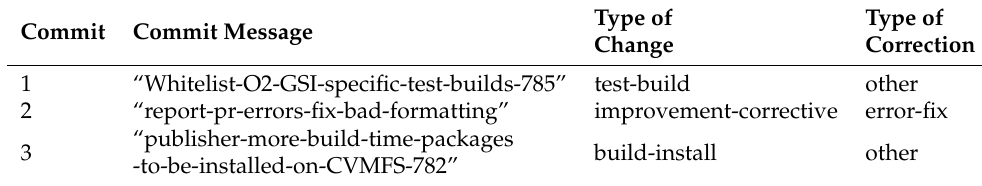
Table 4. Data with examples of